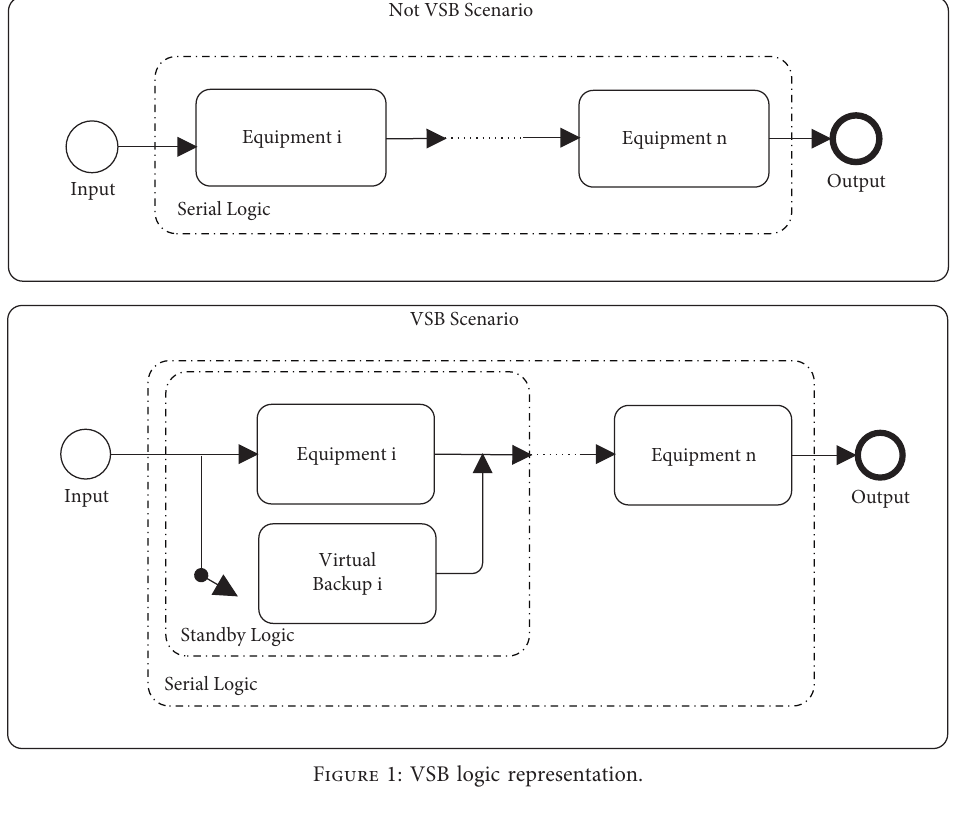
Figure 1: VSB logic representation.